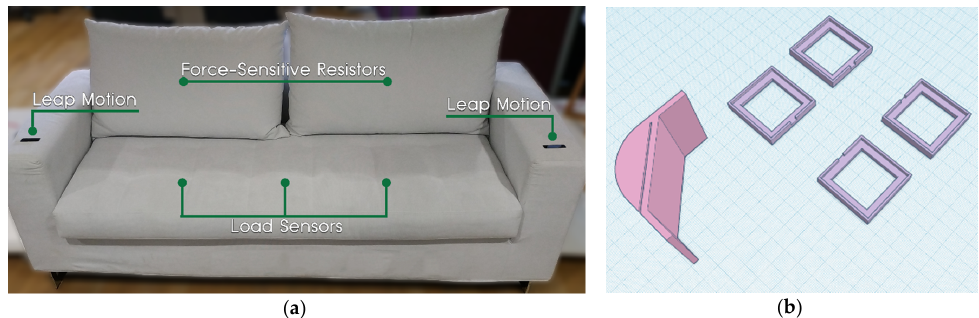
Figure 1. ( a ) The 3D representation of the living room as it resulted from the prototyping phase; ( b ) The current “Intelligent Living Room” setup.